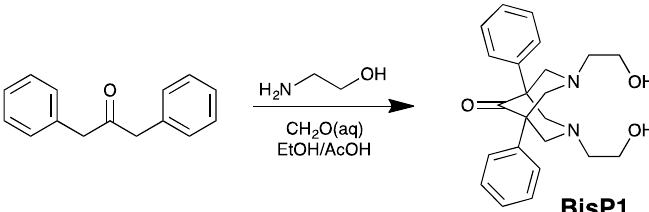
Scheme 1. Synthesis of